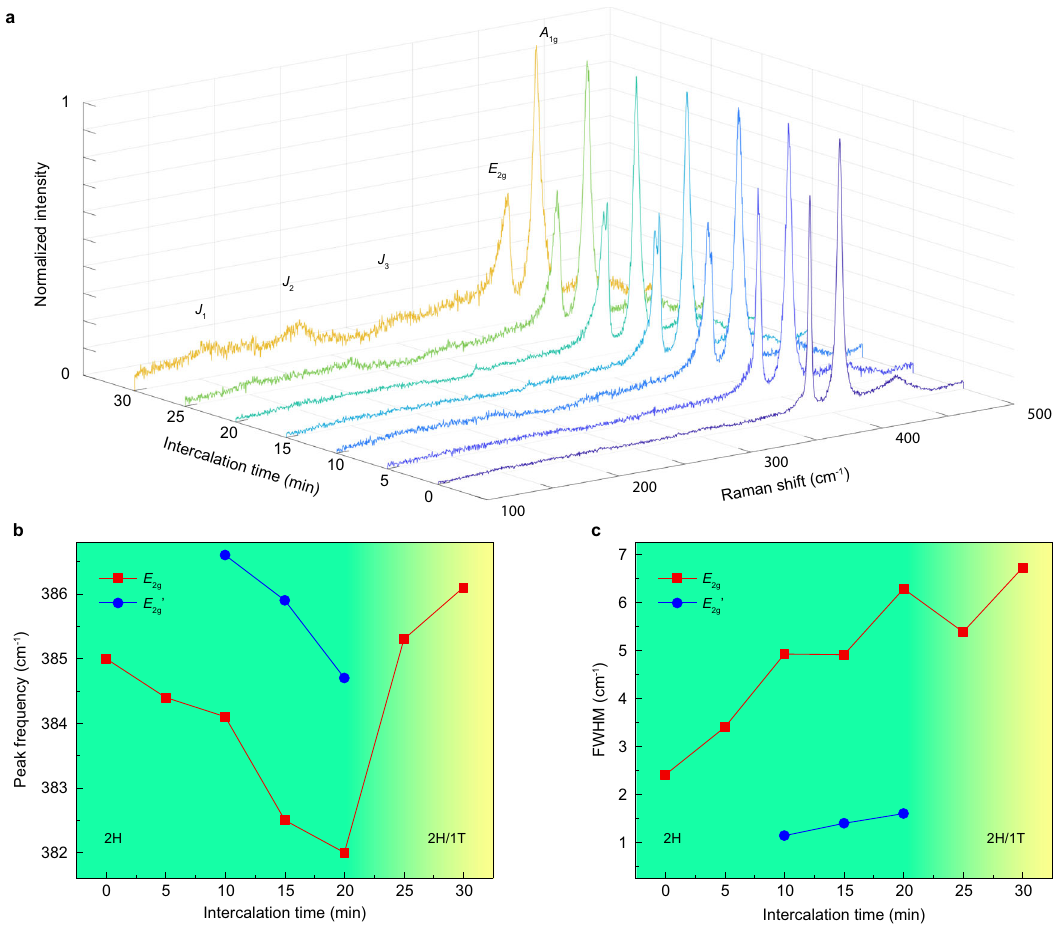
Fig. 3 Raman spectra of the twisted bilayer MoS 2 during intercalation. a Raman spectra of one twisted bilayer MoS 2 for different intercalation times. The variation of the frequency ( b ) and FWHM ( c ) of E 2g and split E 2g ’ modes as a function of the intercalation